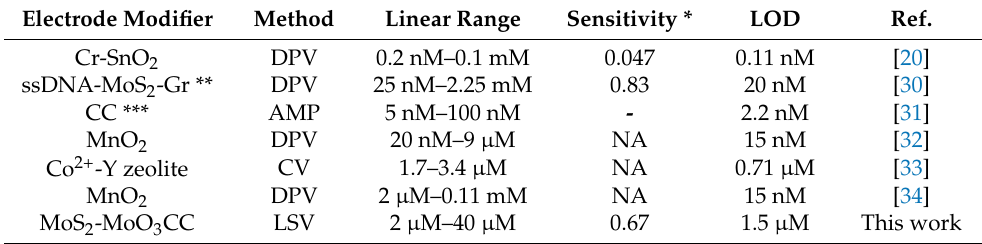
Table 3. Comparison of MoS 2 -MoO 3 CC/SPCE sensor performance with recently reported riboflavin electrochemical sensors.